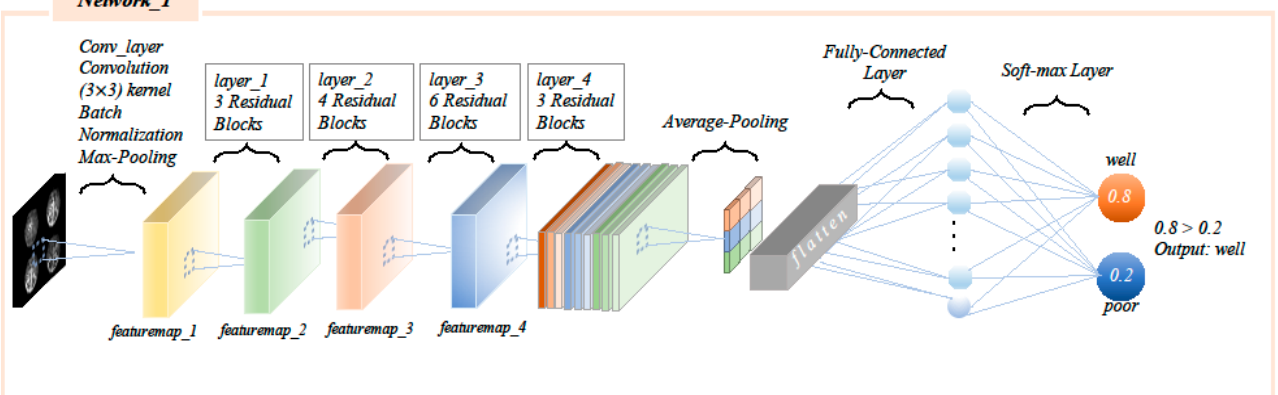
Figure 5. Single image input processing network. The feature maps of the input residual blocks were added element by element to the output feature maps, with the first layer containing three residual blocks, the second layer containing four residual blocks, the third layer containing six residual blocks, and the fourth layer containing three residual blocks. The final fully-connected layer was used as a classifier, mapping the output features into two categories of actual number distributions, and the softmax layer mapped the two real numbers into two (0–1) category probability values, and the sum of the two category probability values was 1. The category with the higher probability value was the final prediction class.